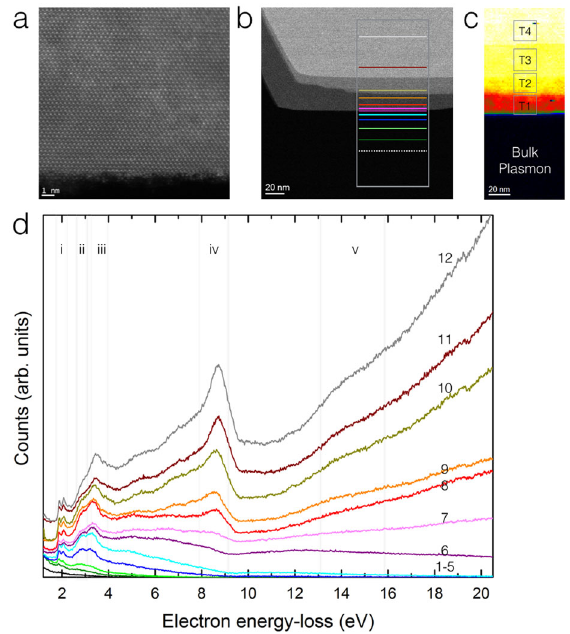
Fig. 2 Scanning transmission electron microscopy (STEM) imaging and low-loss (LL) STEM electron-energy-loss (EEL) spectroscopy analysis of MoS 2 from the edge to the inside of fl ake of increasing thickness. a High-resolution high-angle annular dark fi eld (HAADF) STEM image showing the edge region of a mechanically exfoliated MoS 2 fl ake. b HAADF STEM image showing the region of interest (ROI) ( boxed area ) of which monochromated LL-STEM-EELS were acquired. The edge of the fl ake as well as several steps were present in the ROI. c Integrated intensity map of the bulk plasmon peak (19.7 – 20.7 eV integration window) of the ROI showing the thickness variation ( black = vacuum, from dark blue to white = increasing thickness of the material). The thinnest terrace is annotated T1, the second terrace annotated T2 and the thickest region is annotated T3; they were found to be 5, 8 and 10 layers thick, respectively. d Monochromated LL-STEM-EELS from the different areas as shown in b . The spectra shown were obtained from vacuum (black spectrum 1), aloof mode (spectra 2 – 4), the edge region (spectra 5 – 7), the fi rst terrace T1 (spectrum 8), the step region to the second terrace T2 (spectrum 9), terrace T2 (spectrum 10), terrace 3 (spectrum 11) and terrace T4 (spectrum